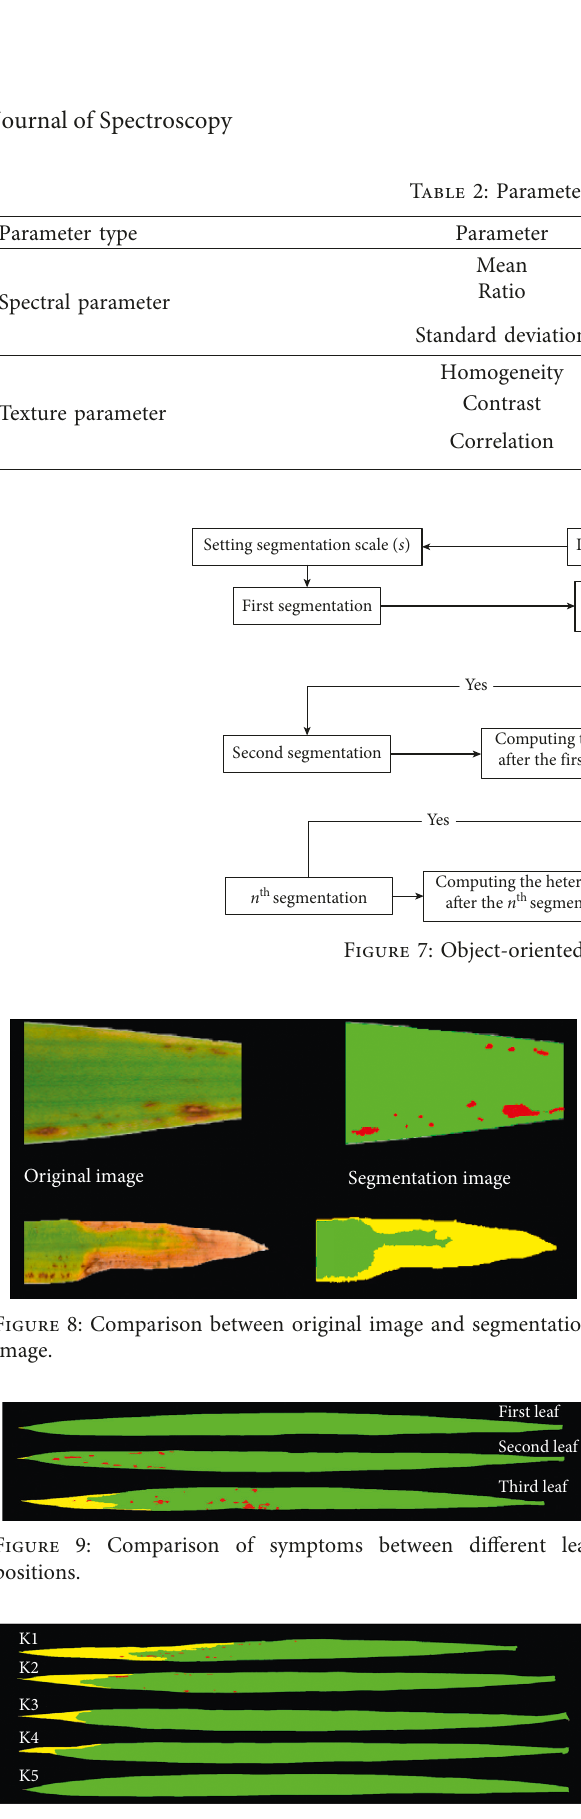
Figure 10: Comparison of symptoms between different K nutrition levels.